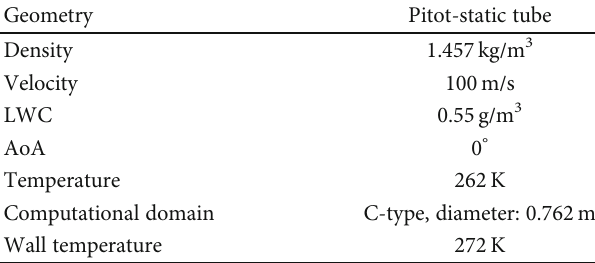
Table 5: Simulation settings of the pitot-static tube cases.